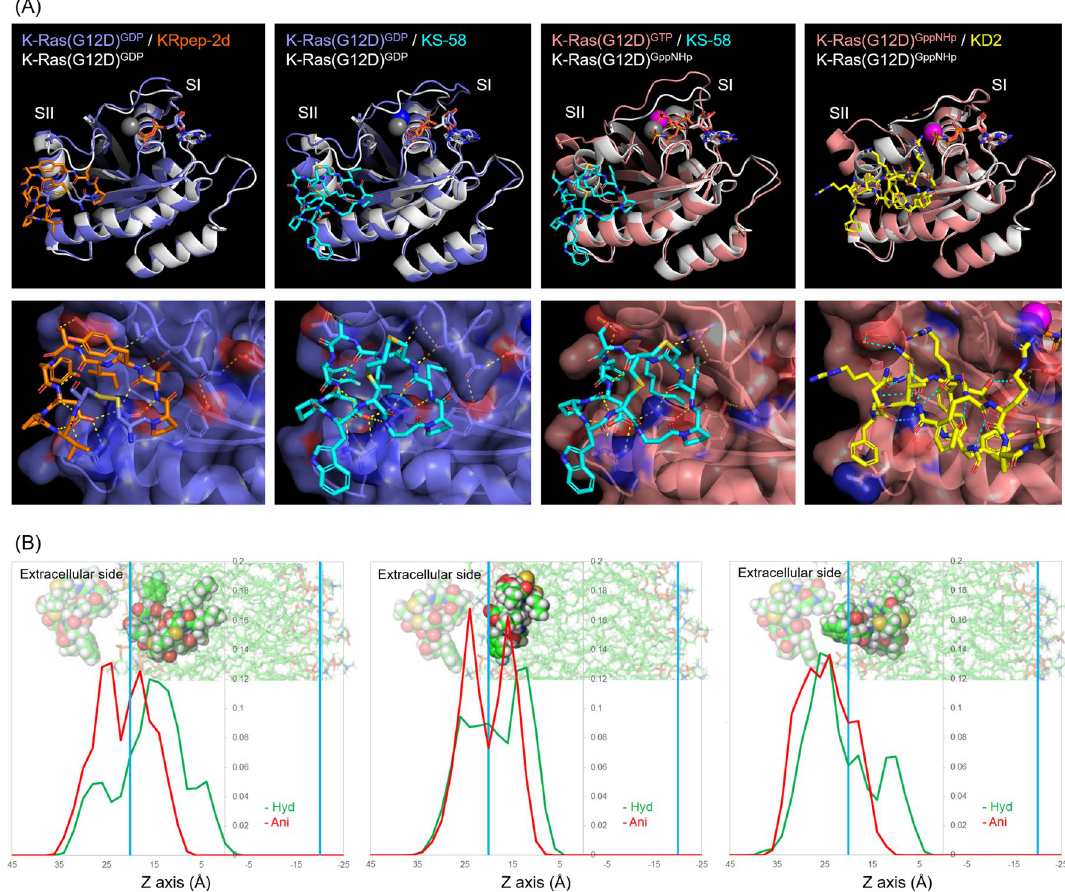
Figure 6. MD simulations of KS-58, KS-58(monocyclic), and KS-58(Ser6Dap). ( A ) Structural comparison of K-Ras(G12D) GDP -binding mode and K-Ras(G12D) GTP -binding mode of KS-58 (stable snap shots) with K-Ras(G12D) GDP (PDB ID: 4EPR), K-Ras(G12D) GDP /KRpep-2d (PDB ID: 5XCO), K-Ras(G12D) GppNHp (PDB ID: 5USJ), and K-Ras(G12D) GppNHp /KD2 (PDB ID: 6WGN). The magnesium ions are presented as large spheres. Dash lines indicate hydrogen bonds. Arg residues at both termini of the KRpep-2d were excluded for clarity. ( B ) Lipid membrane accessibility of peptides in MD simulations. Line graph shows moving positions of underlined atoms of Asp 8 (Cα–CH 2 –COOH, red) and Nle 3 /Anon 5 (Cα–CH 2 –CH 2 –CH 2 –CH 3 , Cα–CH 2 –